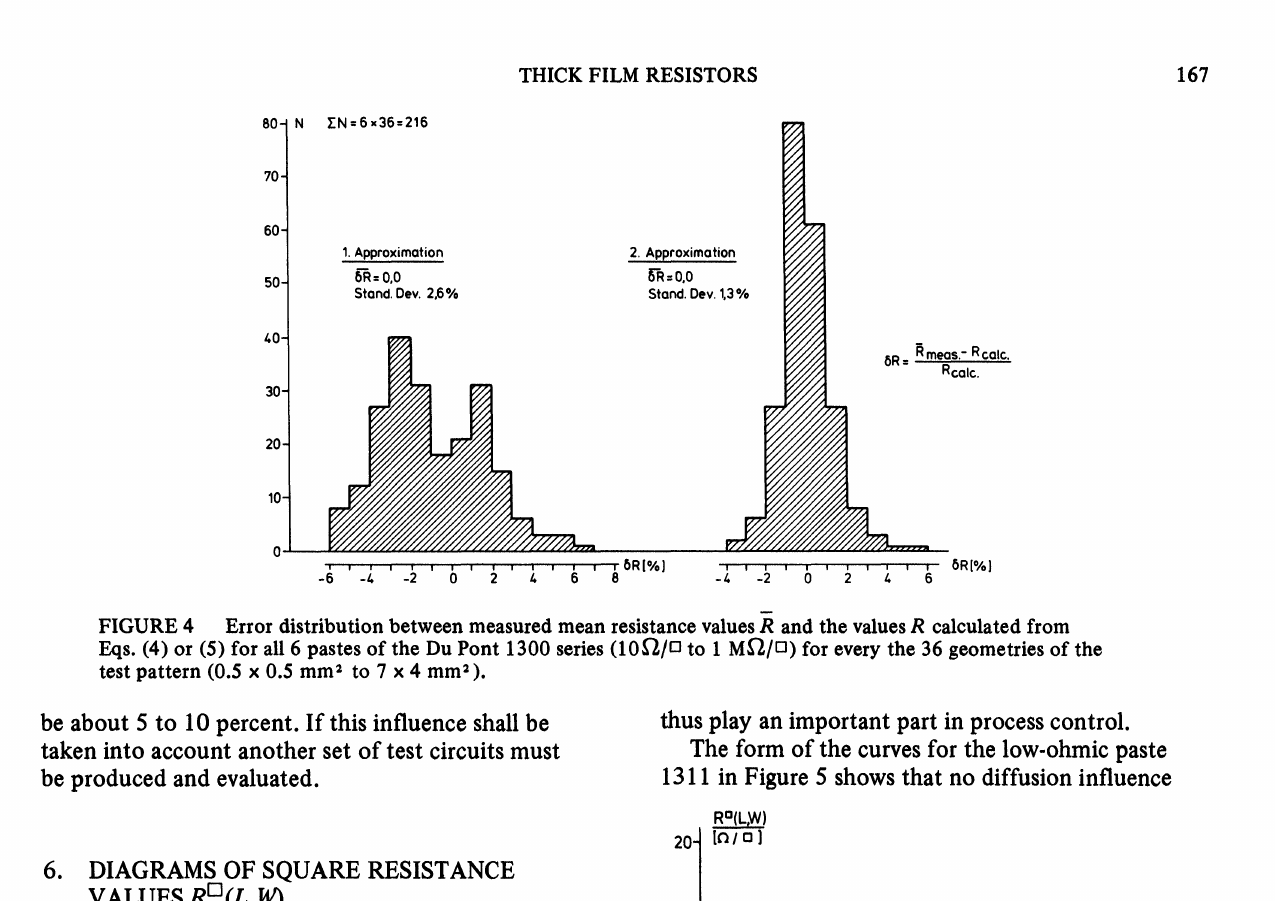
FIGURE 4 Error distribution between measured mean resistance values R and the values R calculated from Eqs. (4) or (5) for all 6 pastes of the Du Pont 1300 series (10/c] to M/n) for every the 36 geometries of the test pattern (0.5 0.5 mm* to 7 4 mm2 ).